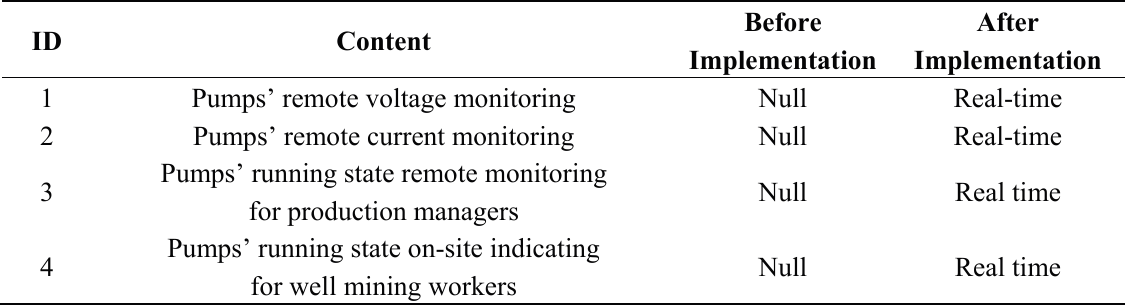
Table 4. Performance analysis before and after the MS-BWME implementation.